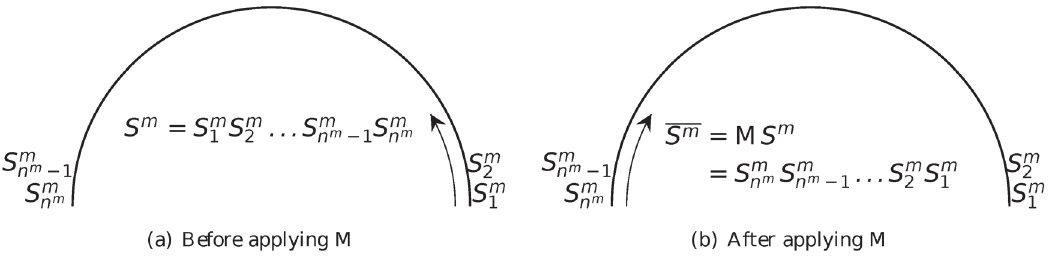
Fig 8. Action of the mirror operator M . The arrow indicates the order in which the labels are listed in the sequence.